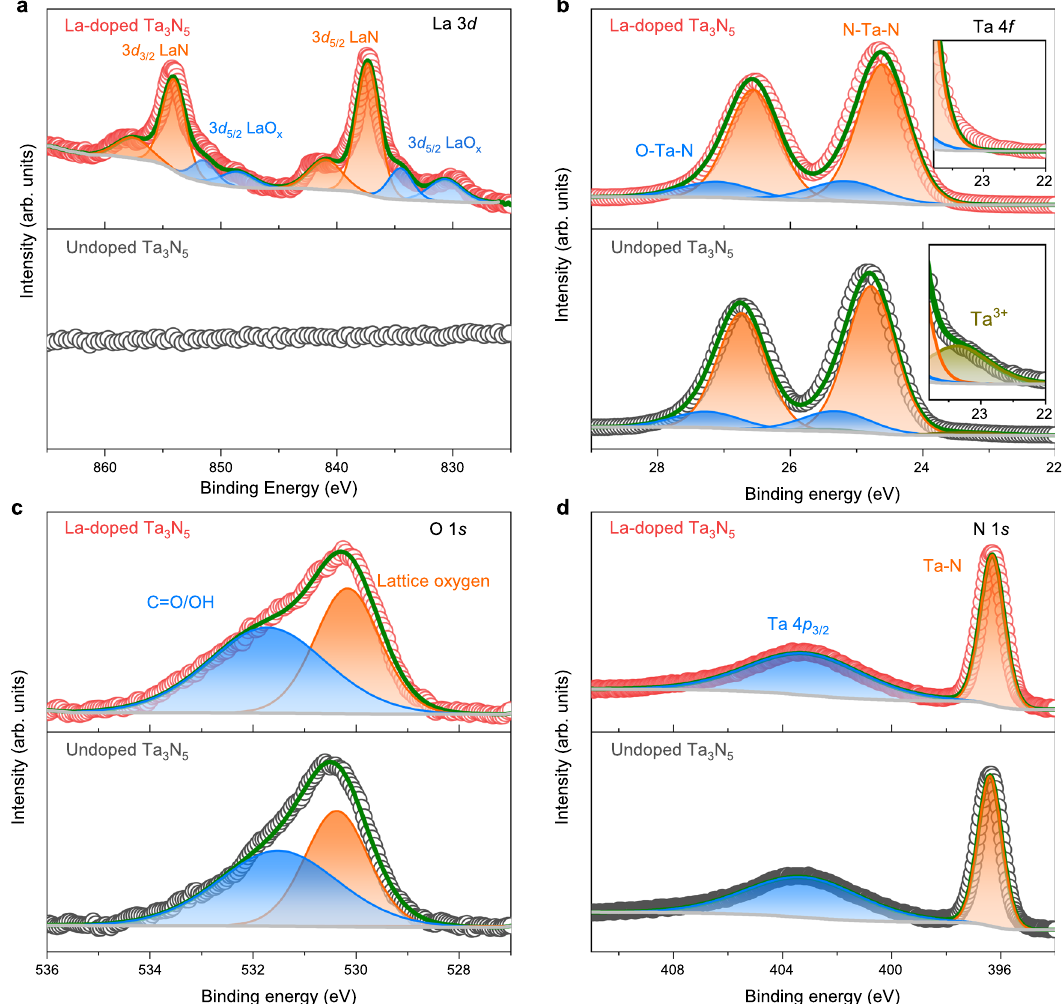
Fig. 2 | XPS core-level spectra of undoped Ta 3 N 5 and La-doped Ta 3 N 5 . a La 3 d peaks. b Ta 4 f peaks. c O 1 s peaks. d N 1 s